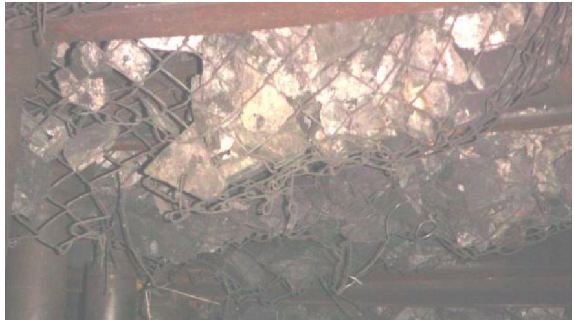
Figure 6: Support in headgate of SLL panel in Zhenchengdi colliery